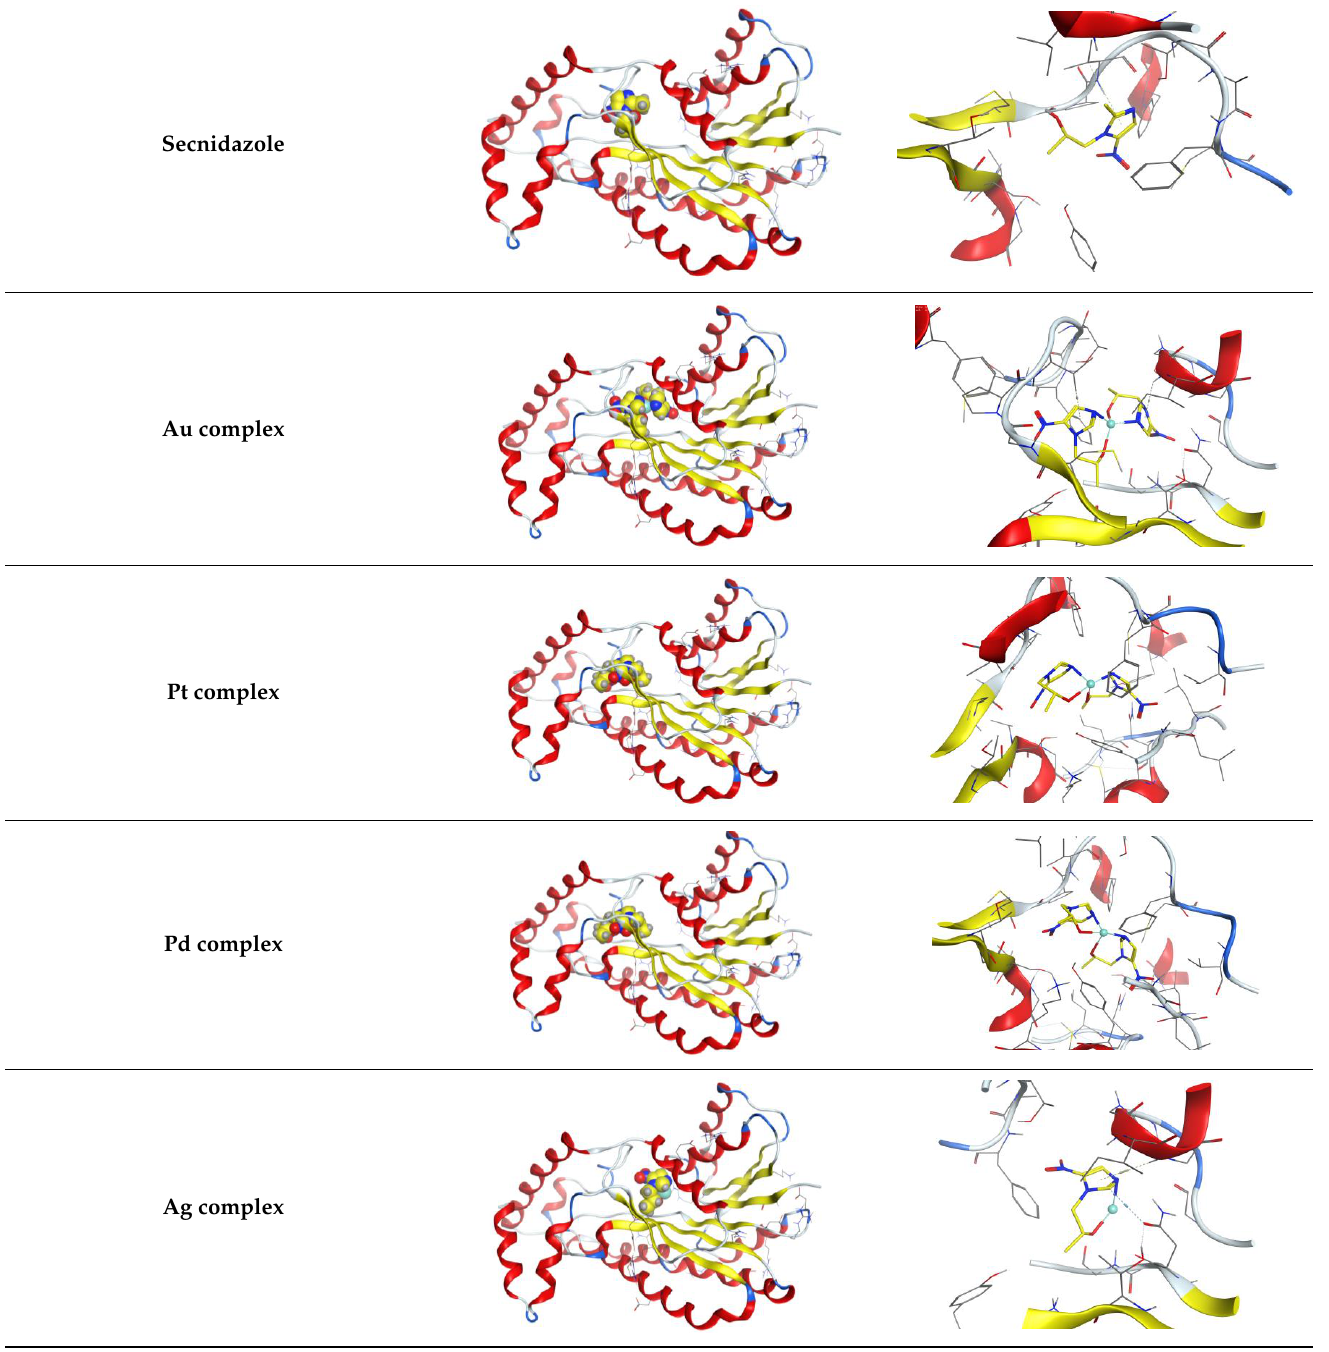
Table 13. 3D and site interaction of the ligand and its metal complexes with 3hb5 protein.